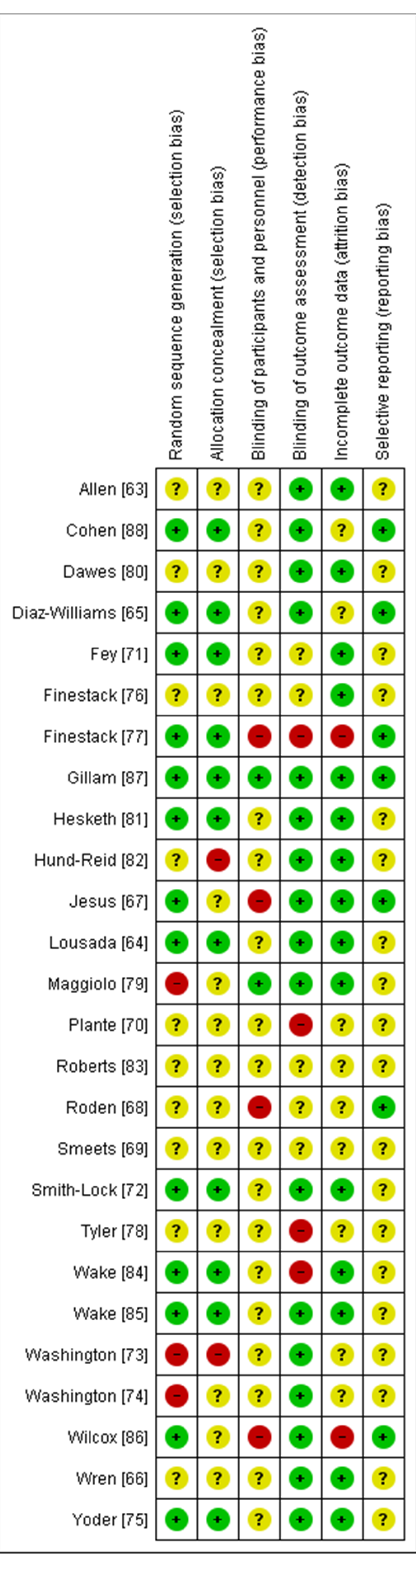
Figure 1. Risk of bias found in individual studies considered in the present review. Green: low bias risk; yellow: unclear bias risk; red: high bias risk [63–88].